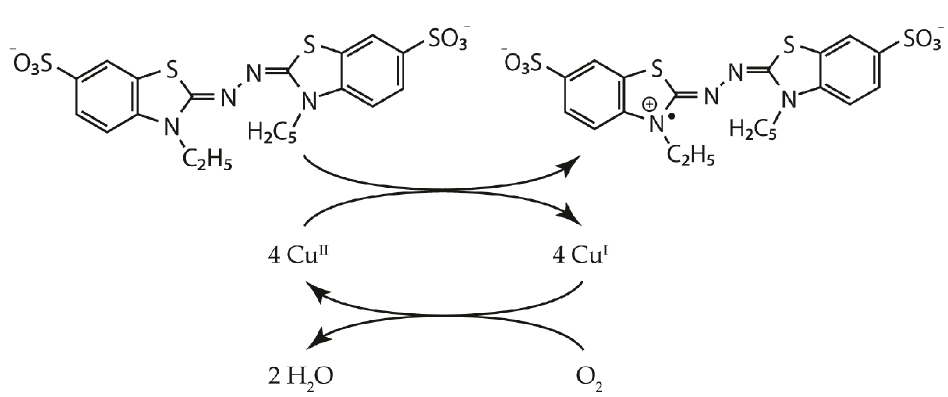
Figure 1. Scheme of a laccase catalytic cycle with 2,2’-azino-bis(3-ethylbenzothiazoline-6-sulfonic acid (ABTS) as a substrate, according to Riva, 2006 [8].